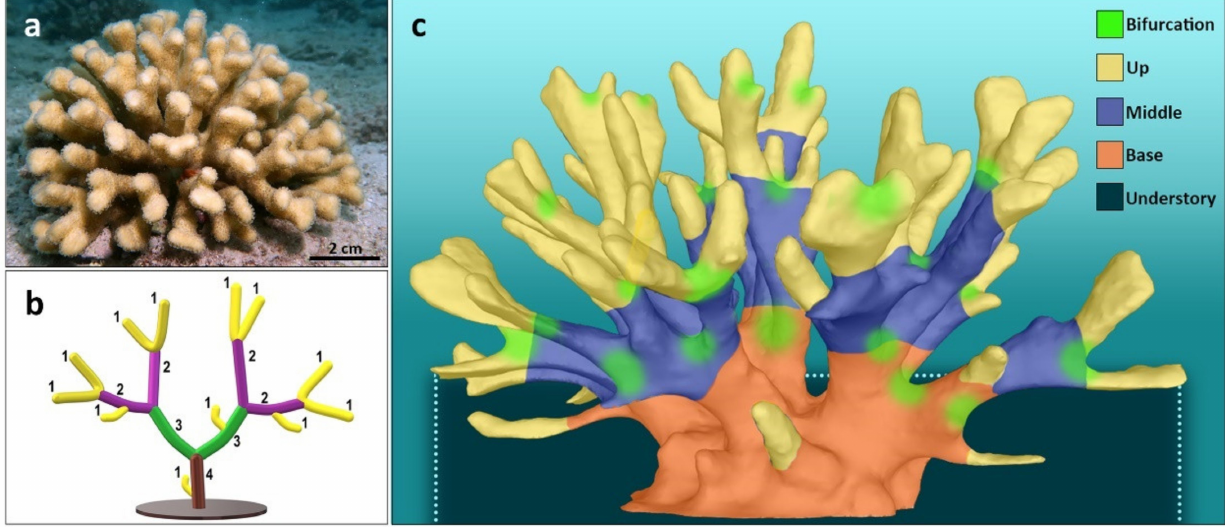
Figure 1. ( a ) A colony of Stylophora pistillata from Eilat’s reef (4 m depth); ( b ) A schematic illustration for Strahler order system applying on a coral canopy. Initiate branches receive the first order (1, yellow branches), and branches that are formed by joining of two branches of the same order i, receive the order i + 1; ( c ) Stylophora pistillata canopy compartments as revealed via the use of branch analyses through the Strahler order technique: Up: the outermost canopy layer, in analogy to the foliage of the tree canopy. This is the canopy peripheral volume that encloses the first Strahler order branches; Base: the canopy two highest Strahler numbers of a specific coral colony, that in analogical to trees create the canopy’s trunk; Middle: middle branches area, this is the space above the base and below the first Strahler branches, resembling the crown area of the tree’s canopy.; Understory: the space found beneath the canopy base that occupies the space between the coral’s substate plain to the parallel first canopy branches. Bifurcation: the branches node, these are the spaces surrounding the initiating axes of all branches above the base. Yellow = ‘up’ compartment; Purple = ‘middle’; Red = ‘base’; Green = ‘bifurcation’; Dark-blue = ‘understory’. Part c was extracted from a S. pistillata skeleton using Autodesk ReCap Photo and Photoshop